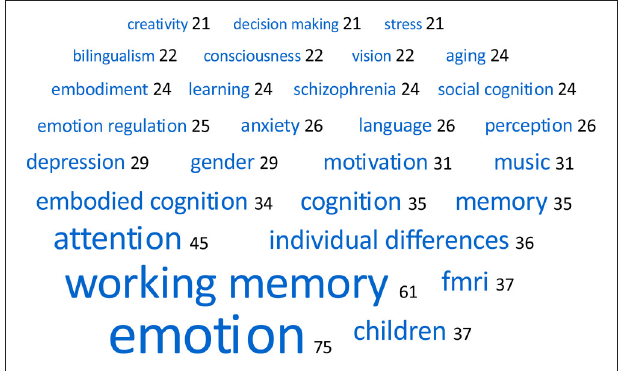
FIGURE 1 | Word cloud of the 28 keywords that are shared by more than 20 (1%) of the 2,046